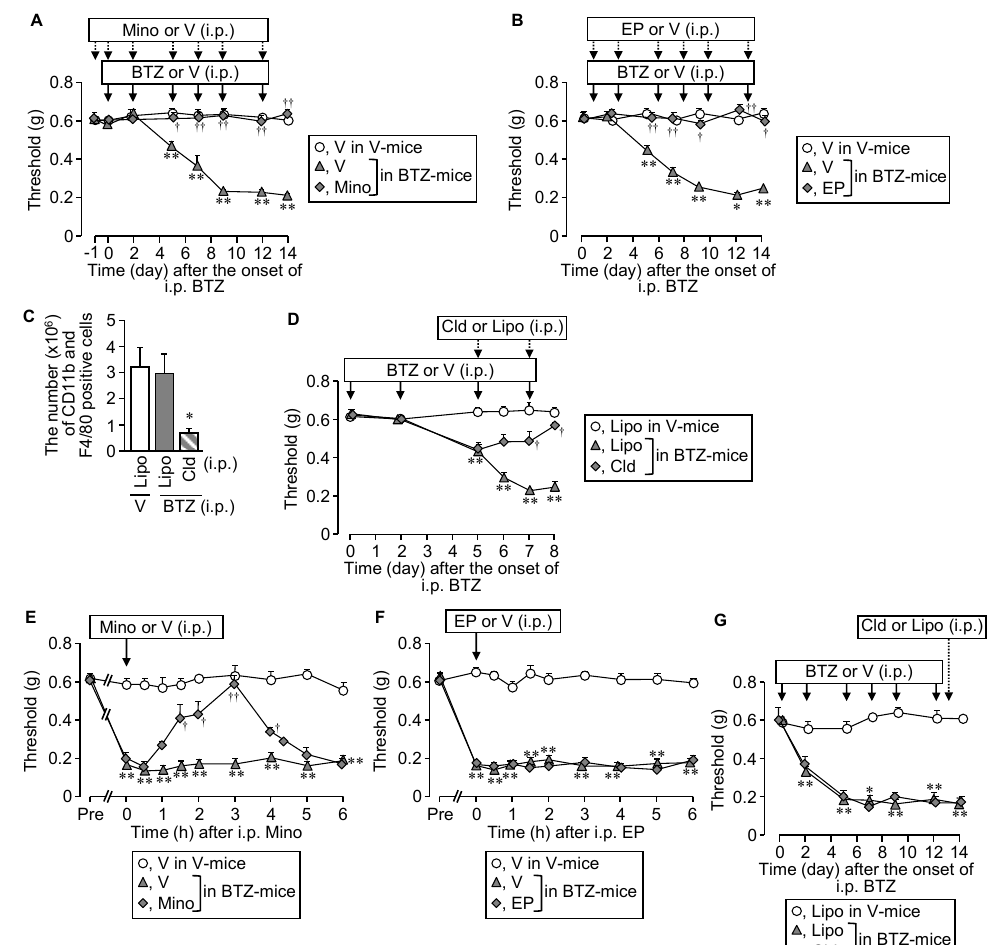
Figure 4. Effect of macrophage inhibition or depletion on the development of CIPN in mice treated with bortezomib. Bortezomib at 0.4 mg/kg or vehicle was administered i.p. on day 0, 2, 5, 7, 9, and 12. ( A , B ) Preventive effects of minocycline, a macrophage/microglia inhibitor, and ethyl pyruvate, known to inhibit HMGB1 release from macrophages. Minocycline at 30 mg/kg was administered i.p. once 24 h before the onset of bortezomib treatment and repeatedly 30 min before each dose of bortezomib ( A ). Ethyl pyruvate at 80 mg/kg was administered i.p. 1 h before each dose of bortezomib ( B ). ( C , D ) Effect of macrophage depletion with liposomal clodronate on the development of CIPN caused by bortezomib. The mice received two i.p. administrations of liposomal clodronate at 1.05 mg/mouse or the control liposome on days 5 and 7 after the onset of bortezomib treatment, and successful macrophage depletion in the isolated spleen was confirmed by counting CD11b- and F4/80-positive macrophages in flow cytometry ( C ). ( E – G ) Effects of minocycline, ethyl pyruvate, and liposomal clodronate on the established CIPN in mice treated with bortezomib. The mice received a single i.p. administration of minocycline or ethyl pyruvate on day 14 and liposomal clodronate or the control liposome on day 13 after the onset of bortezomib treatment. V, vehicle; BTZ, bortezomib; Mino, minocycline; EP, ethyl pyruvate; Cld, liposomal clodronate; Lipo, control liposome. Data show the mean with S.E.M for 5–6 ( A , B , D , E , F ), 7–9 ( G ), or 5 ( H ) mice. * p < 0.05, ** p < 0.01 vs. V in V-treated mice ( A , B , E – G ) or Lipo in V-treated mice ( C , D , G ). † p < 0.05, †† p < 0.01 vs. V in BTZ-treated mice ( A , B , E ) or Lipo in BTZ-treated mice ( D ).